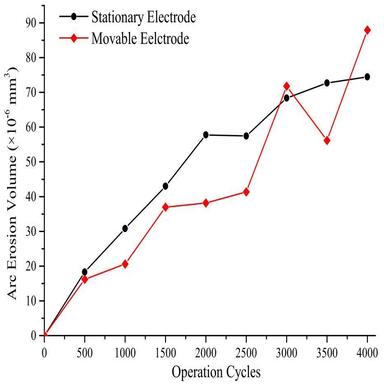
Variations of arc erosion volume between initial and eroded electrodes as a function of the number of switching operations.